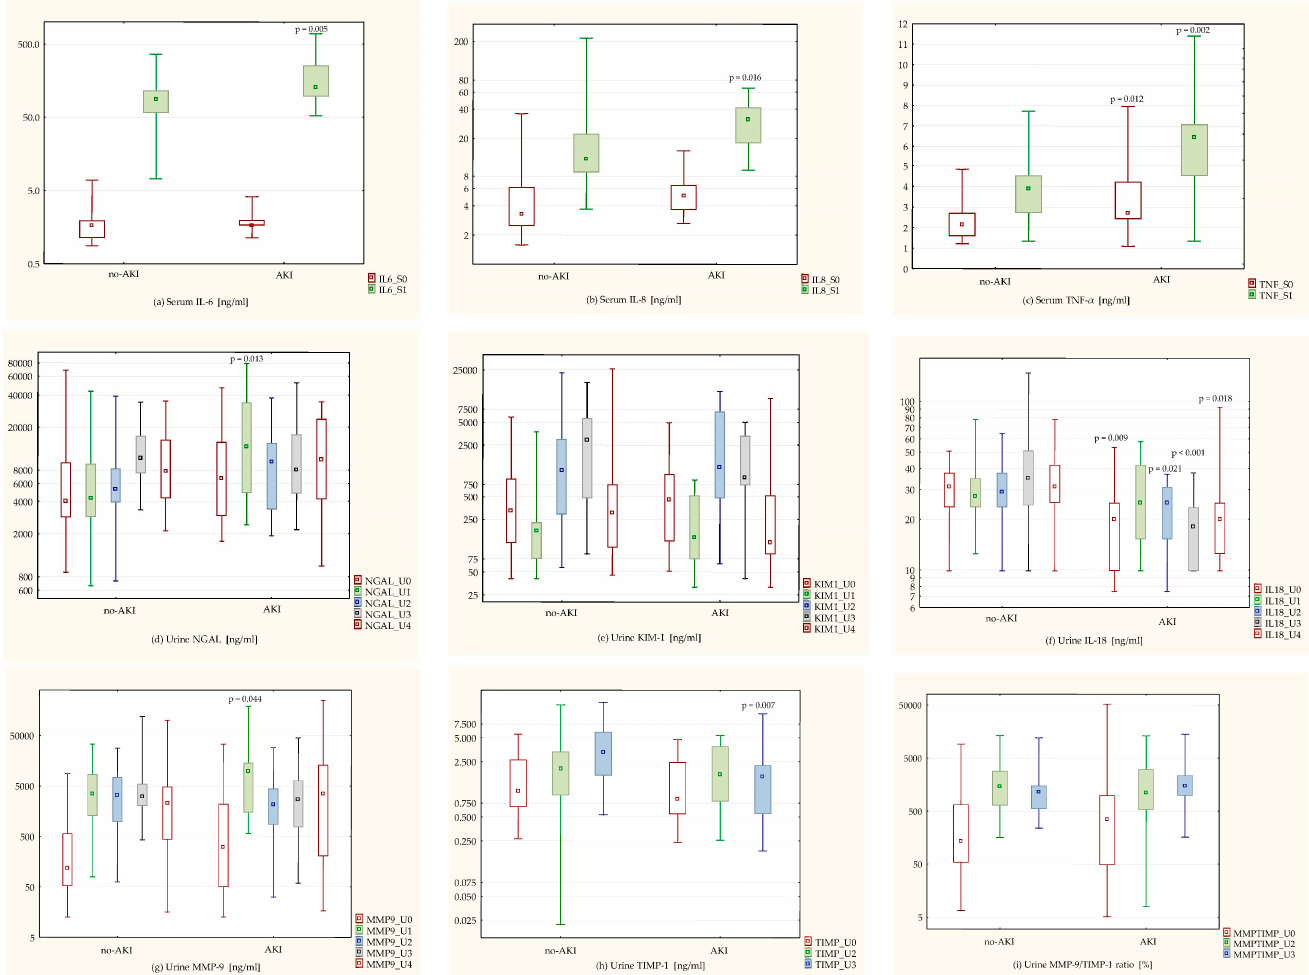
Figure 1. Biomarkers’ concentrations ( a – i ) at the designated time points in patients without AKI vs. with AKI. Sampling time descriptors in the legend (S0, S1, U0–U4) are consistent with the time points mentioned in Table 2. Dots on the chart represent the median value; boxes represent values between the 1st and 3rd quartile (Q1–Q3), and whiskers represent the extreme values. For values that differed significantly between the study and control group ( p < 0.05), p -values are written above the upper whisker in the AKI